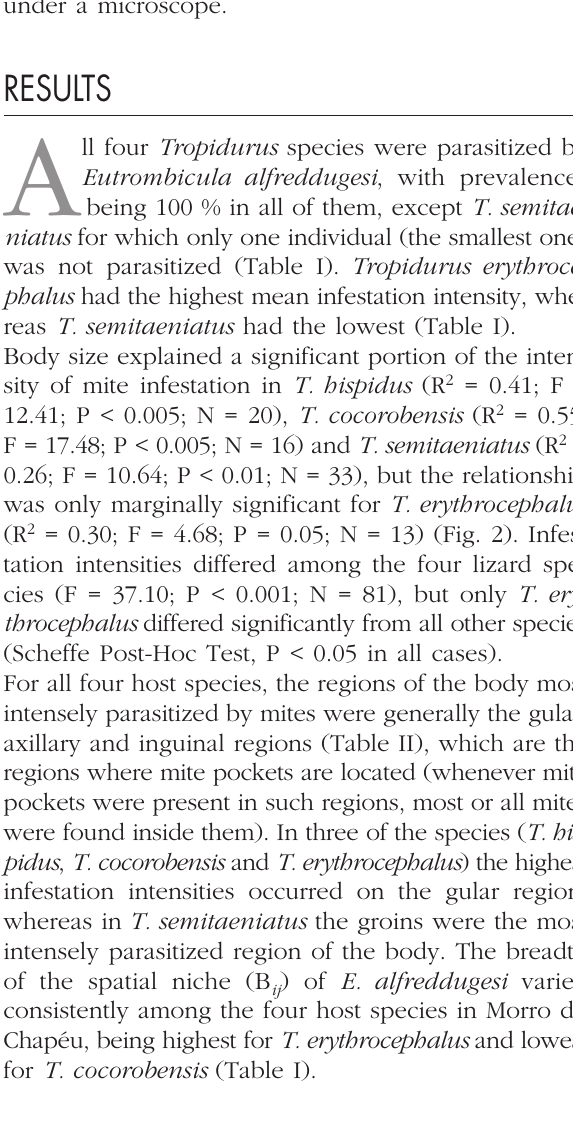
Table I. – Prevalence, mean intensity (± SD, with range in parentheses), and spatial niche breadth (B bicula aff. alfreddugesi associated to four species of Tropidurus in Morro do Chapéu, northeastern Brazil. Sample size (N) and mean body size (with range in parentheses) for each lizard species is also